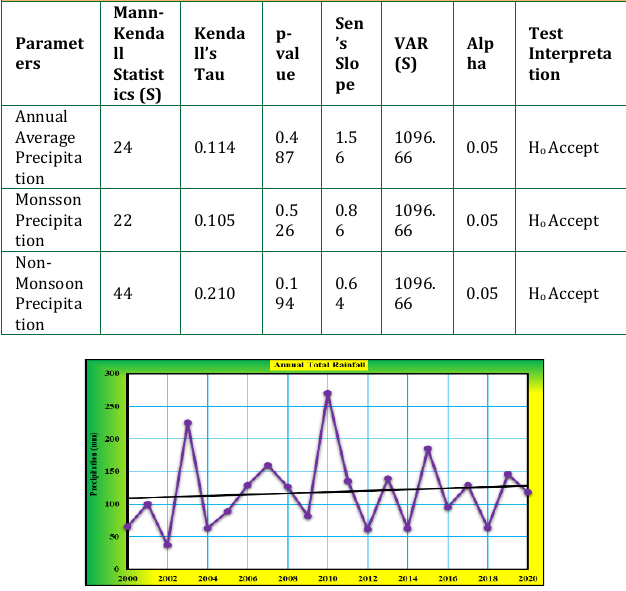
Table 2: Illustrate Rainfall (Annual, Monsoon and Non-Monsoon) results of Ghotki district from 2000-2020